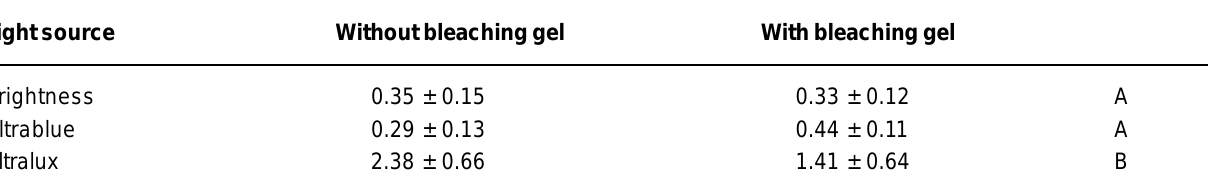
Different letters indicate statistically significant difference ( α =0.01)